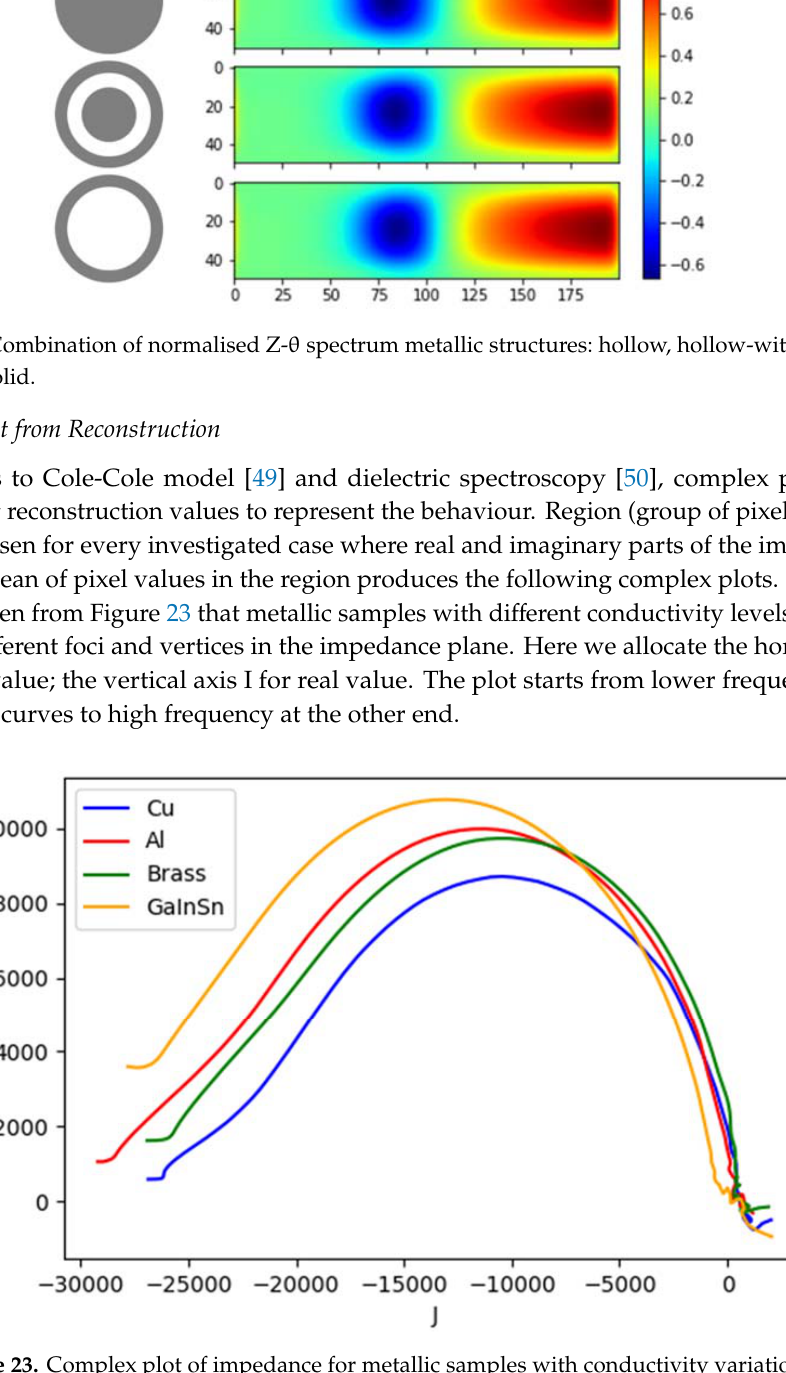
Figure 24. Complex plot of impedance for metallic structures.